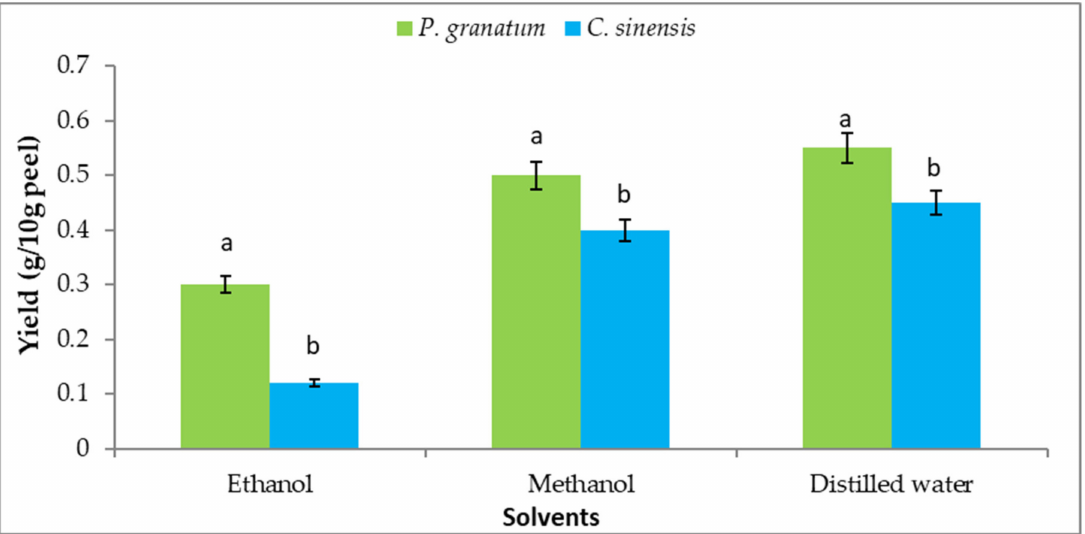
Figure 7. Yield of extracts from different peels utilizing various solvents. Each value is a mean ( ± SD) of three replicates. The different letters on the same bar show a significant difference according to Duncan’s test at p ≤